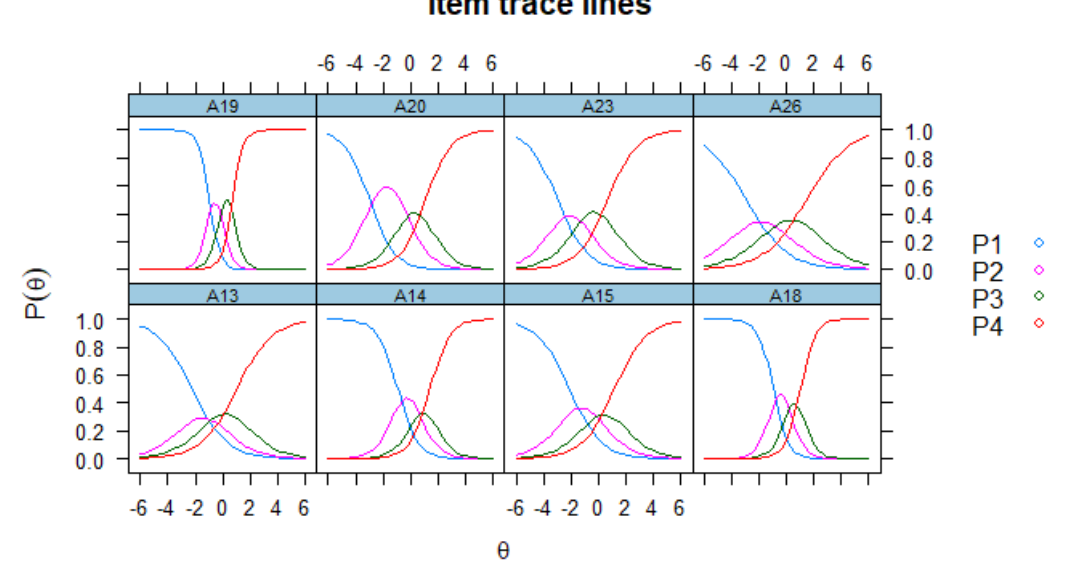
Figure 2. ICCs of the Religious Needs component.